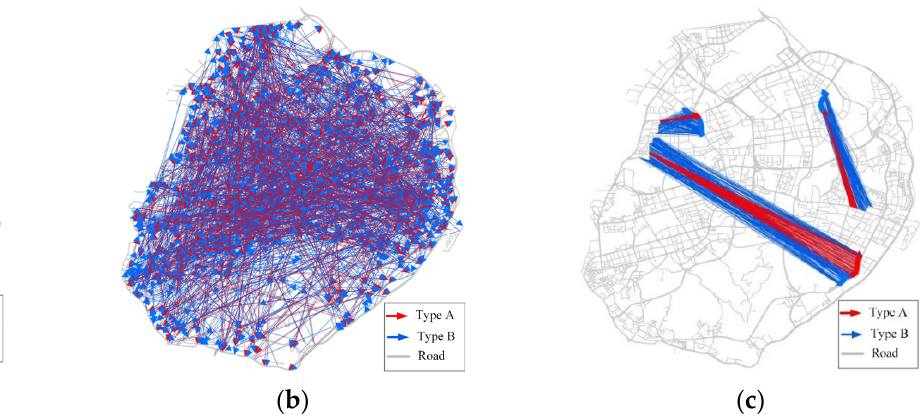
Figure 1. Spatial distribution of simulated datasets: ( a ) simulated dataset 1; ( b ) simulated dataset 2; ( c ) simulated dataset 3.